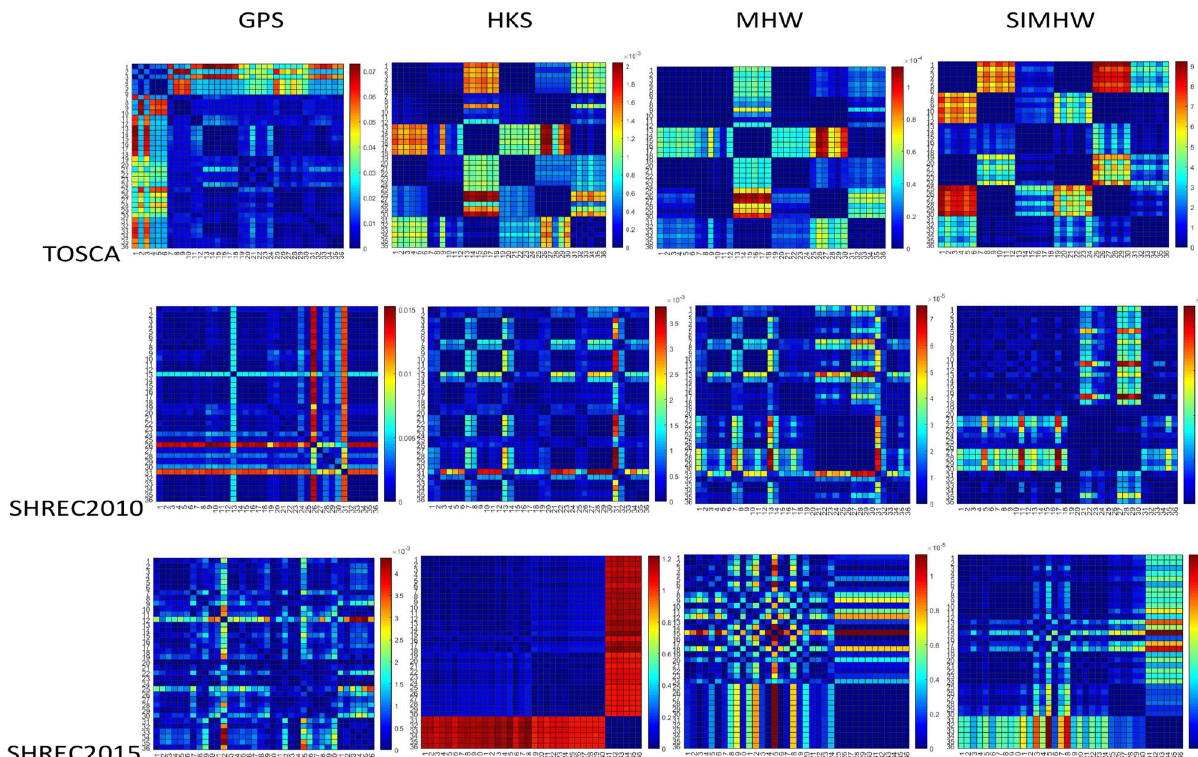
Figure 7. Visual thermodynamic diagram comparison results based on MHD distance matrix.